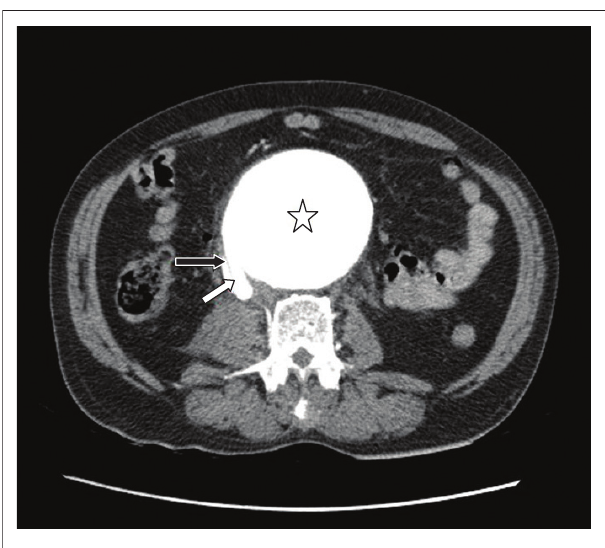
FIGURE 1: Axial contrast-enhanced computed tomography showing a large infrarenal aneurysm (star) having a fistulous communication (white diagonal arrow) on its right posterolateral wall with inferior vena cava (black